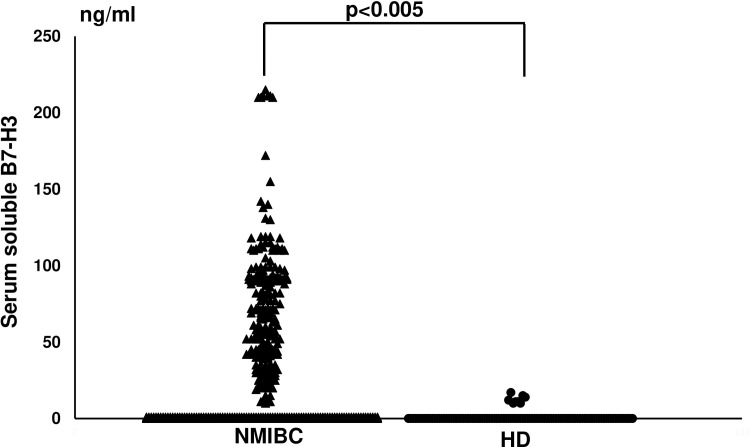
Detection of serum soluble B7-H3 (sB7-H3) in patients with non-muscle invasive bladder cancer (NMIBC).We next examined the concentration of sB7-H3 in the HD and patients with NMIBC. Sera from 555 patients with NMIBC and 103 HD were diluted to 1:10 in PBS and tested by ELISA as described in Materials and Methods. The data were analyzed using the Mann-Whitney U test followed by multiple regression analysis (p<0.005).